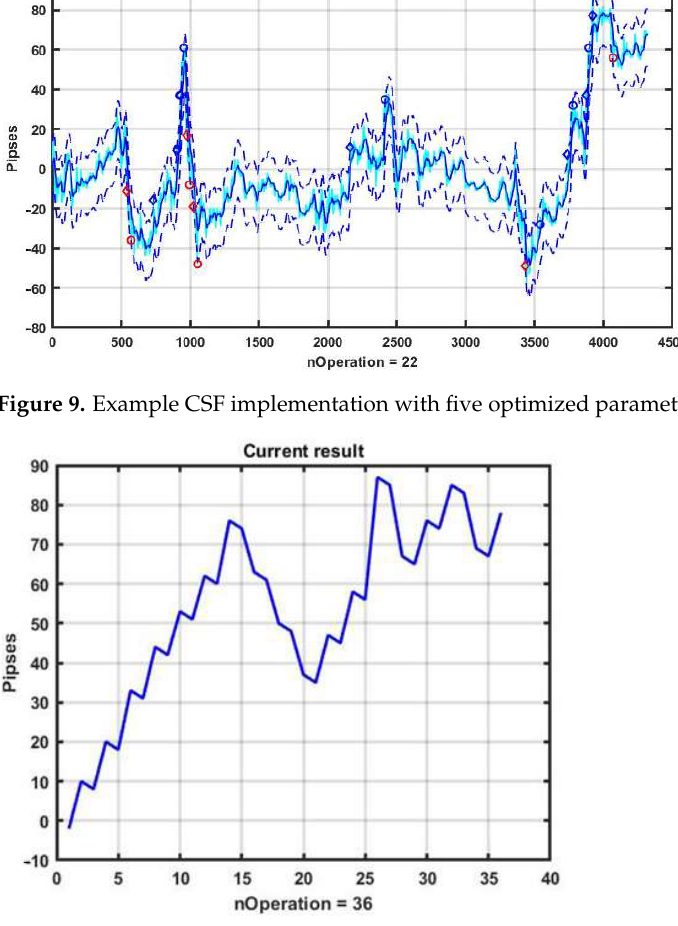
Figure 10. Performance in the case of using CSF in the previous example.